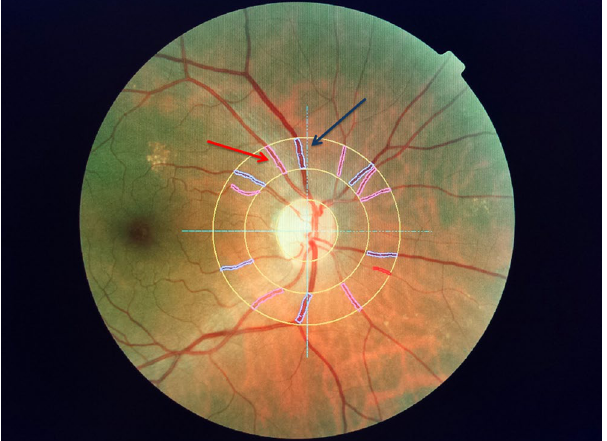
Figure 1. Example of an image obtained by retinal vessel analyzer (RVA) and then processed by Imedos software that provided the caliber of the vessels emerging from the optic disc. The assessments of the arterial calibre and of the vein calibre were taken between 1 and 2 disc diameters from the margin of the optic disc, in correspondence with the major superior temporal arteries (Red Arrow) and vein (Blue Arrow) of the right